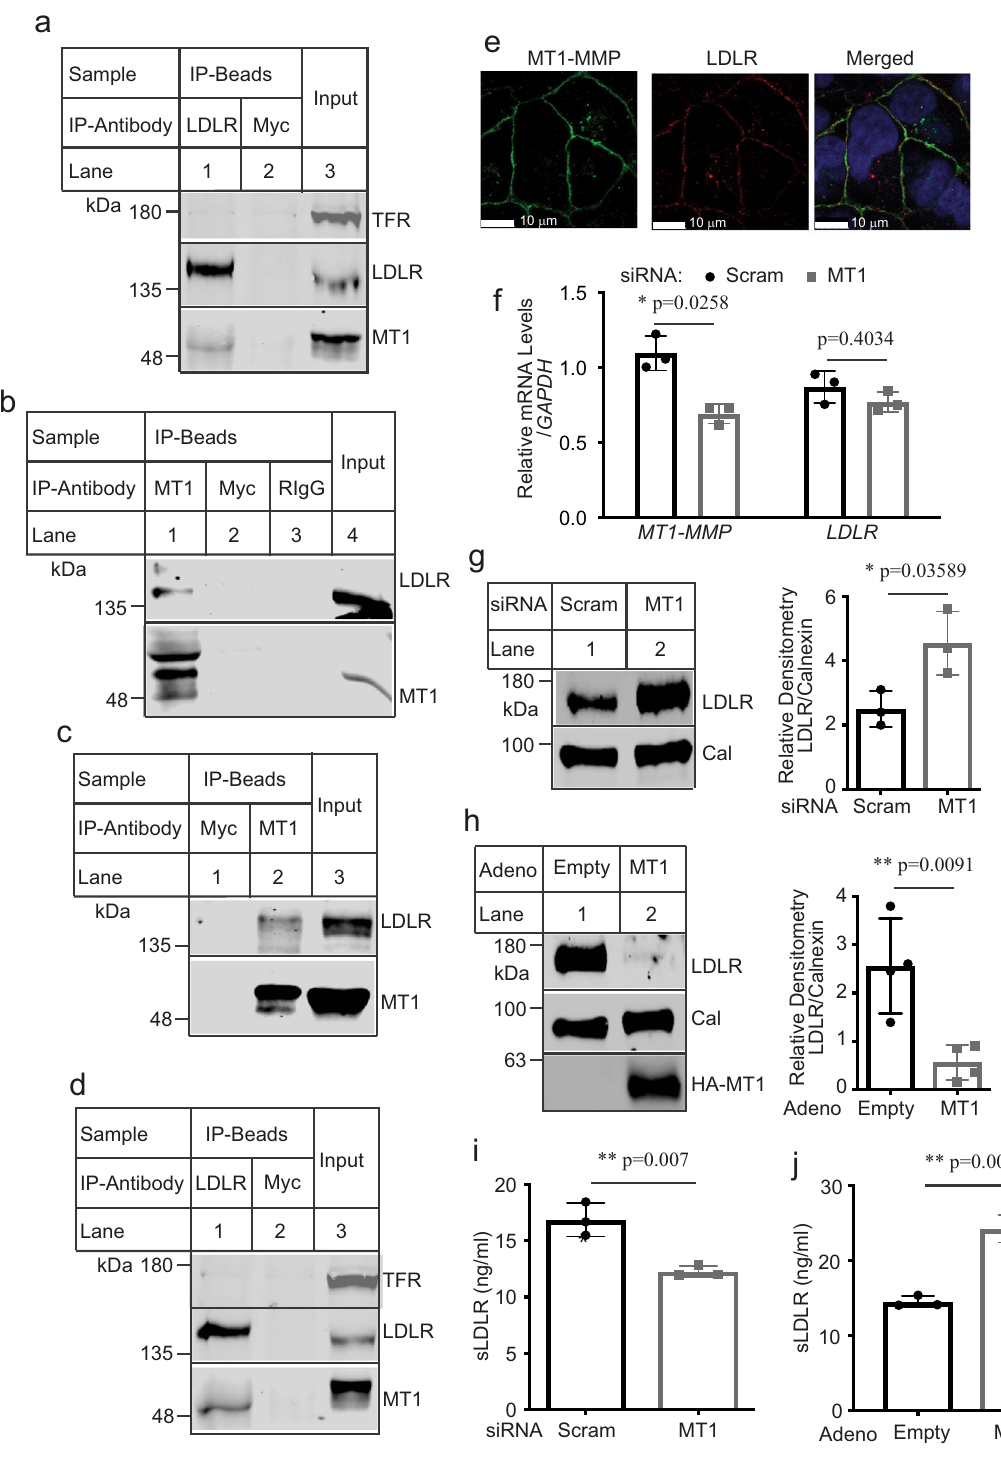
mouse liver were also not affected by hepatic de fi ciency of MT1- MMP (Fig. 4f). On the other hand, MT1 LKO mice displayed a mild but signi fi cant reduction in plasma levels of total cholesterol (Fig. 4g). FPLC data showed that cholesterol levels in both LDL and HDL fractions were mildly reduced (Fig. 4h). Conversely, plasma TG levels were comparable in MT1 LKO and MT1 Flox mice (Supplementary Fig. 3e). Similarly, the lack of MT1-MMP in hepatocytes did not signi fi cantly affect the levels of liver TG or total cholesterol (Supplementary Fig. 3f, g). To con fi rm